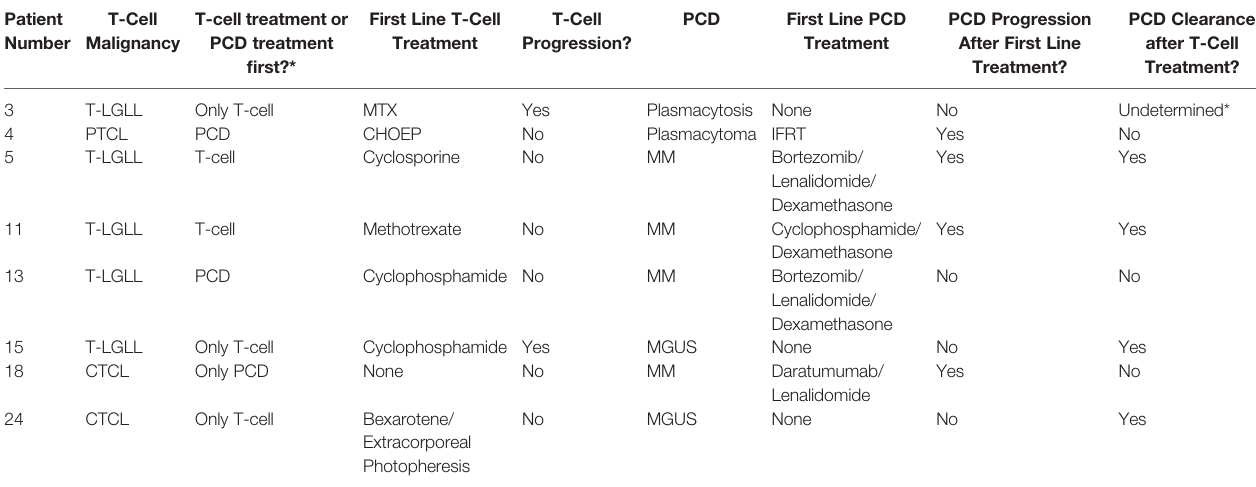
TABLE 5 | Patients with clearance of PCD clone. Patient T-Cell T-cell treatment or Number Malignancy PCD